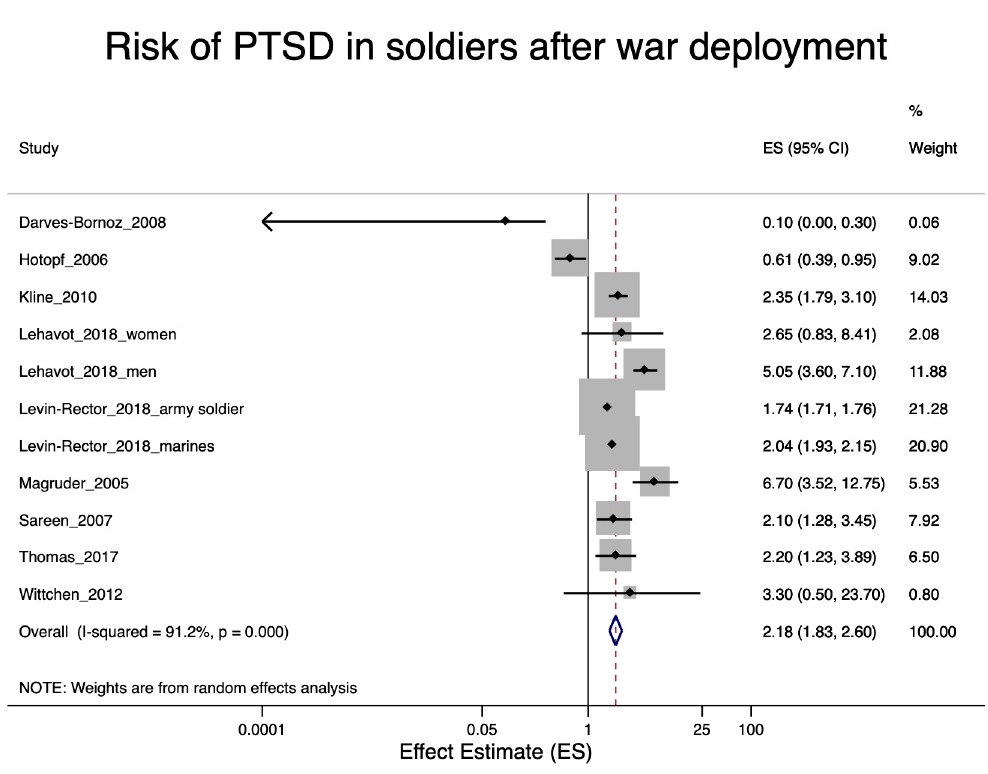
Figure 2. Forest plot of soldiers after war deployment and the estimates of effect size (ES) for post-traumatic stress disorder (PTSD).